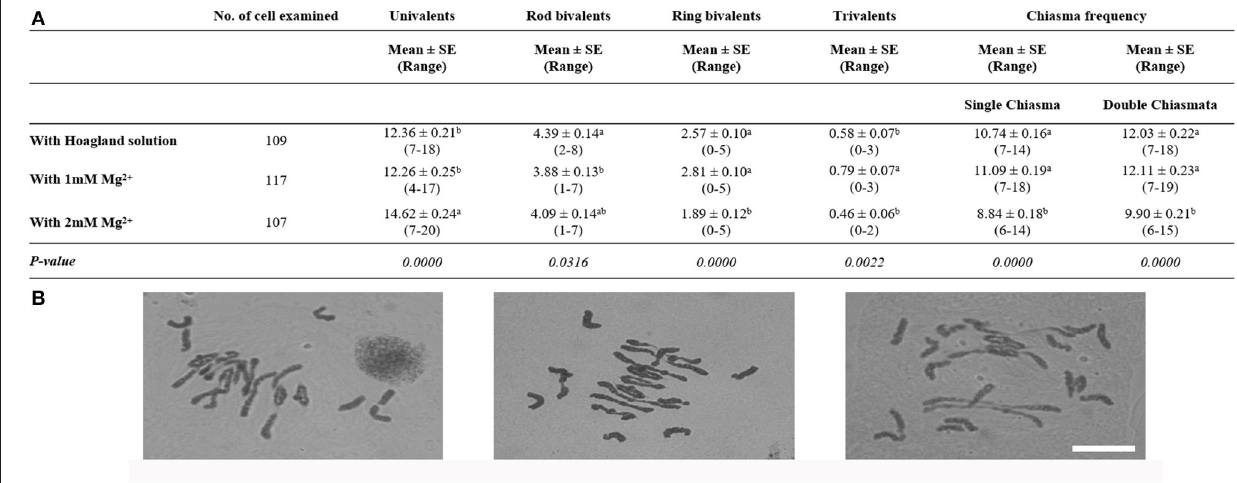
Frontiers in Plant Science |